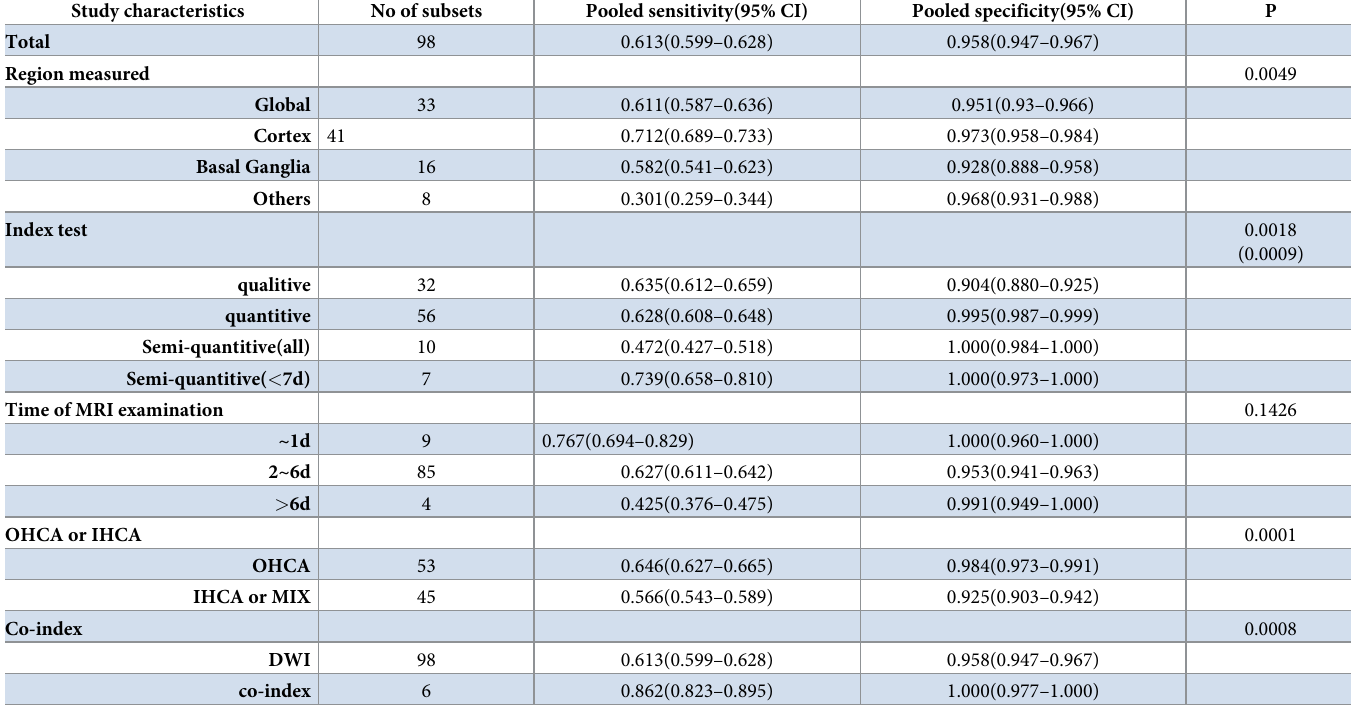
Table 3. Subgroup analysis among the different study